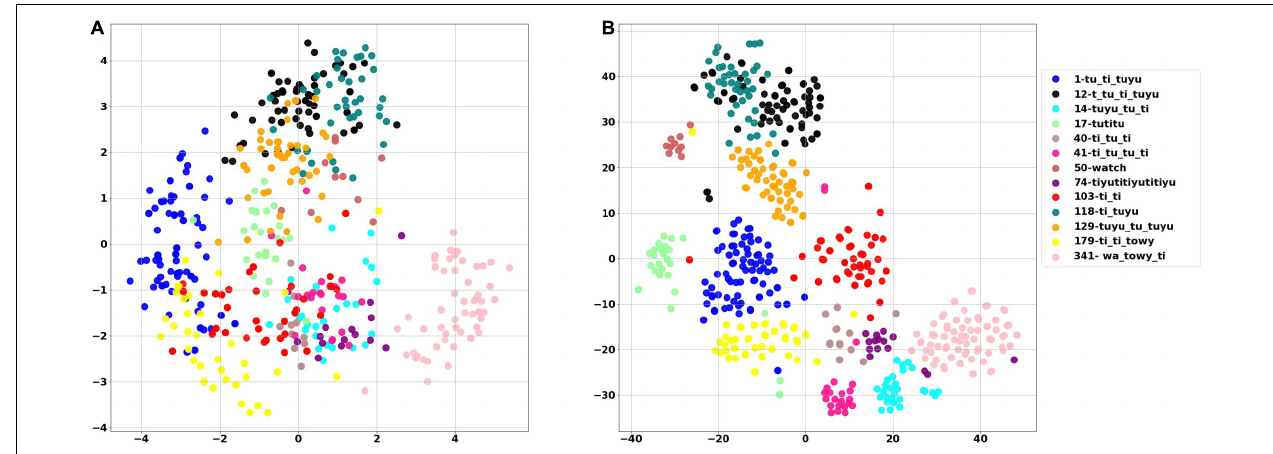
FIGURE 8 | The PCA score plot of the first two PCs of the word analysis (A) , and tSNE analysis (B) where each color represents one unique naming tag. Instances of each word are grouped together by both unsupervised algorithms. For example, all of the pale pink points are grouped together, as they all represent word number 314—" wa towy ti. "